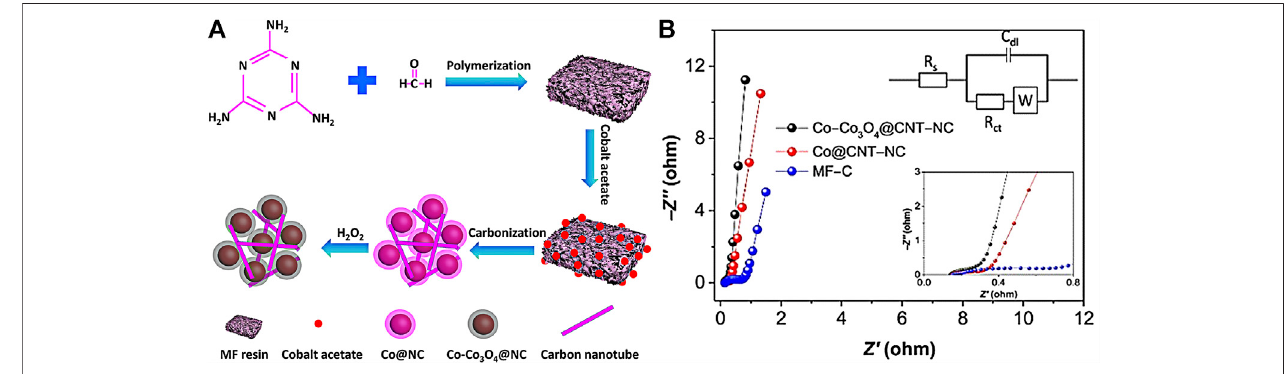
FIGURE 11 | (A) Schematic illustration of the synthesis of Co-Co 3 O 4 @CNT-NC and (B) EIS plots for various materials (upper inset is the equivalent circuit and the lower one is the impedance data in the high-frequency range). Adapted with permission from Zou et al. (2018). Copyright 2018, Elsevier.